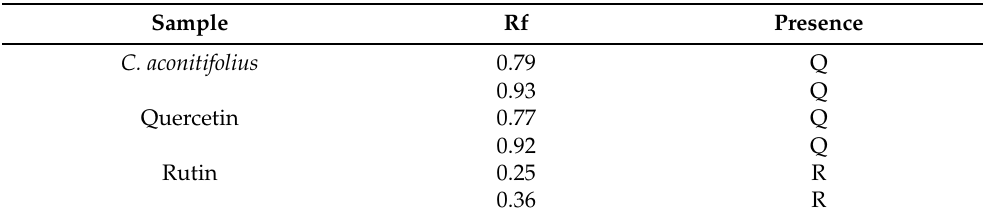
Table 1. Retention factor values of C. aconitifolius extract and standard controls obtained during thin-layer chromatography (duplicate).